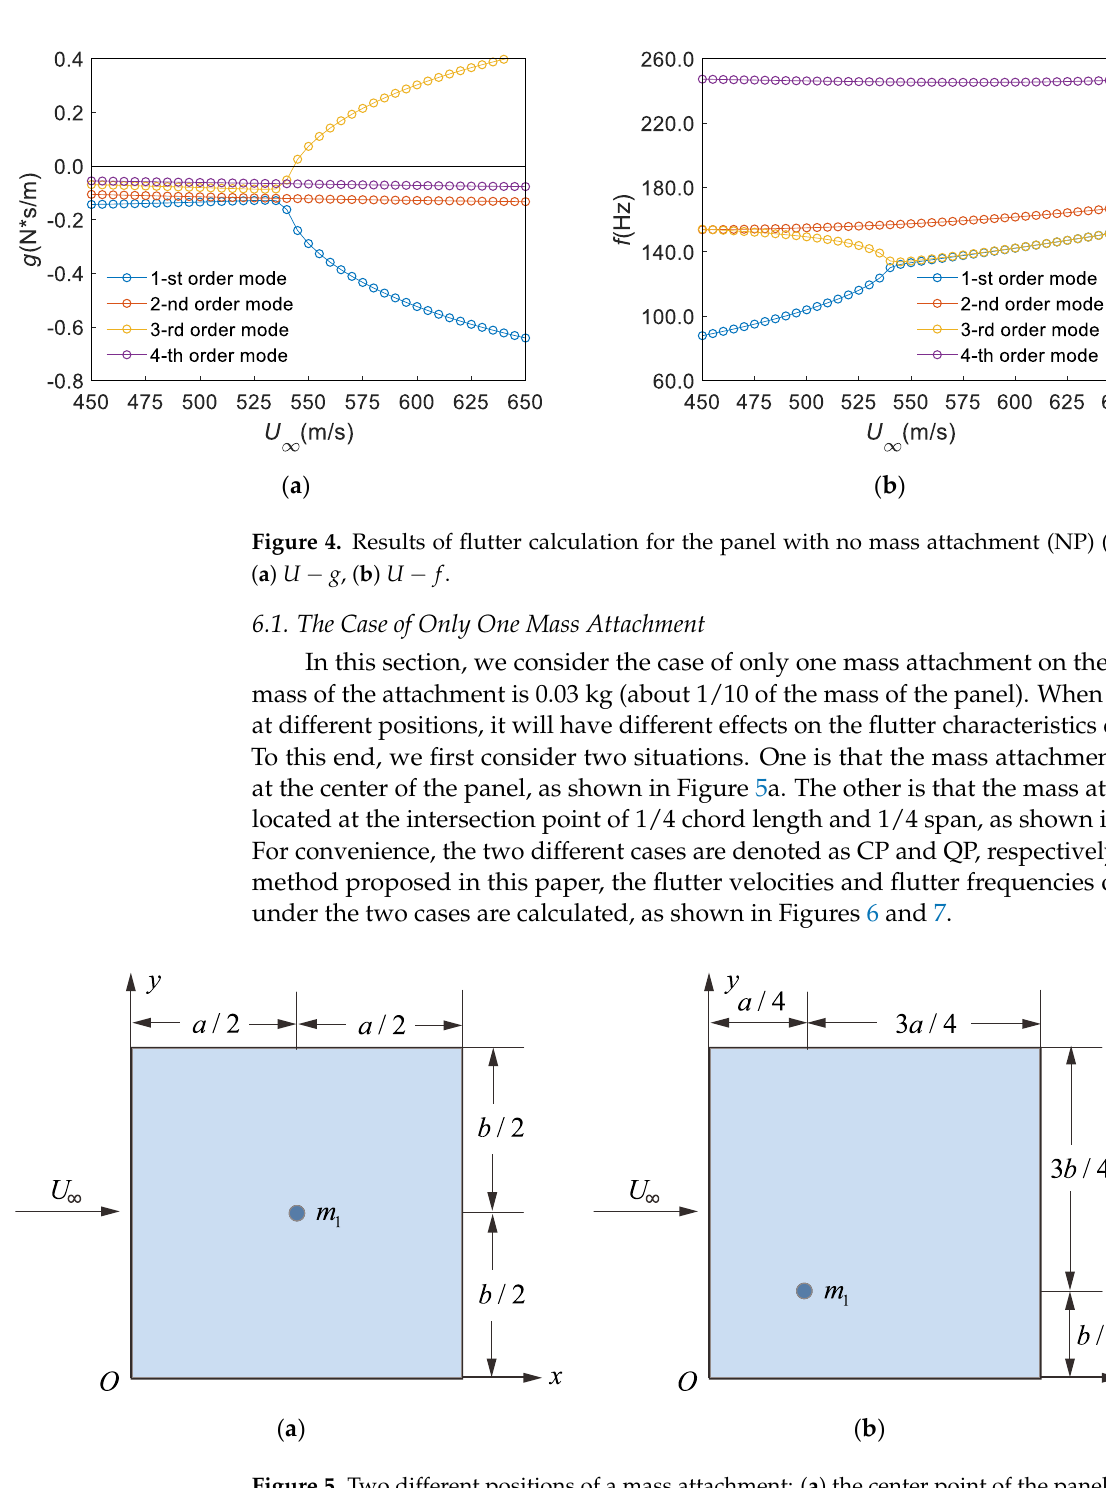
Figure 3. Flutter velocities and flutter frequencies change with the number of truncated modes r ( 2.0 Ma  ): ( a ) flutter velocities, ( b ) flutter frequencies. 